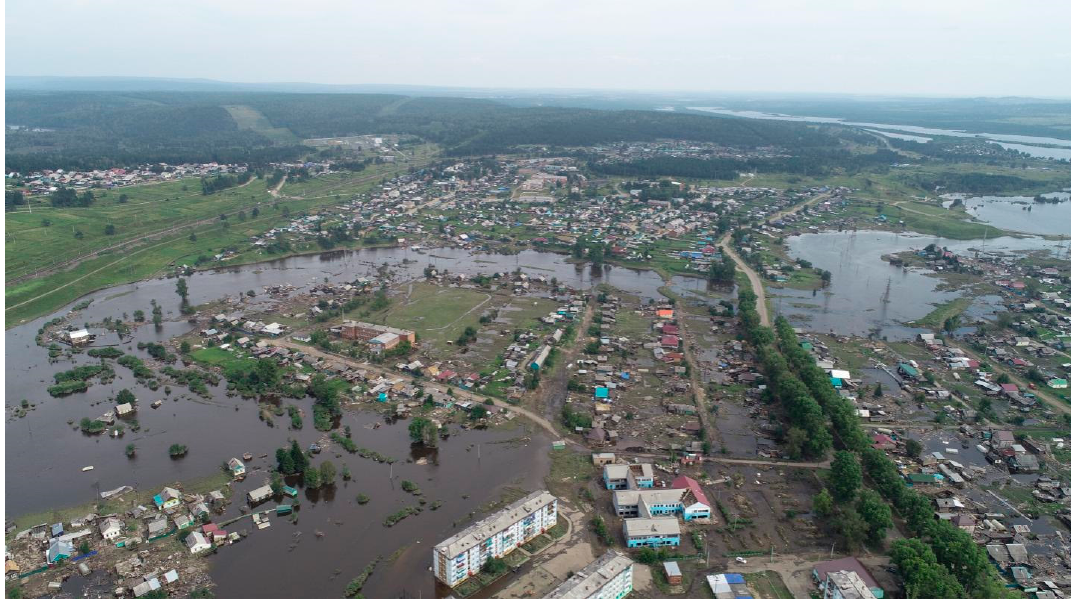
Figure 17. Panorama of a district, Tulun. Coordinates: 54°32 ′ 38.9315 ″ N, 100°37 ′ 41.9411 ″ E. The image was taken on 2 August 2019.